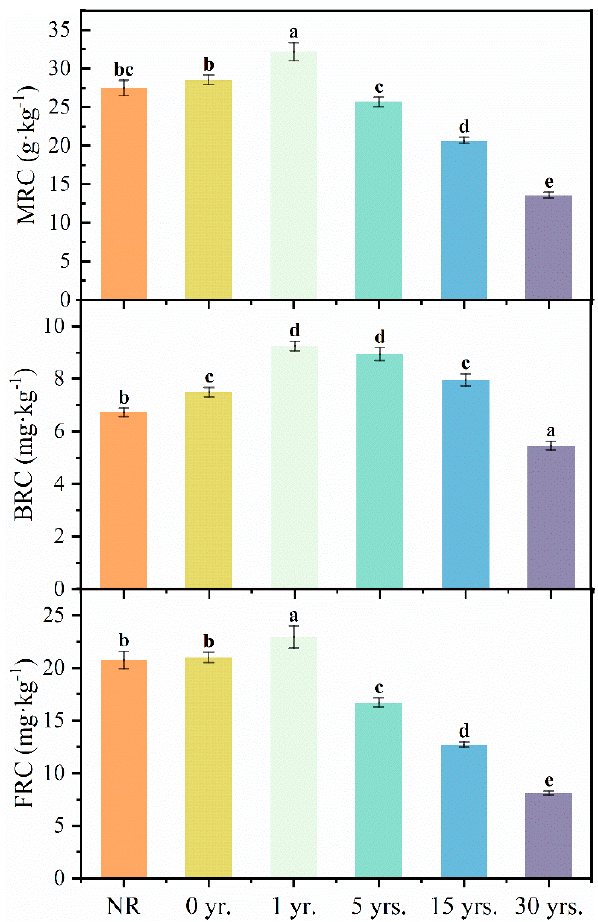
Figure 3. Concentrations of MRC, BRC, and FRC in soils of natural reserved land and cultivated land. Note: Different letters indicate significant difference among the land use types at p < 0.05.